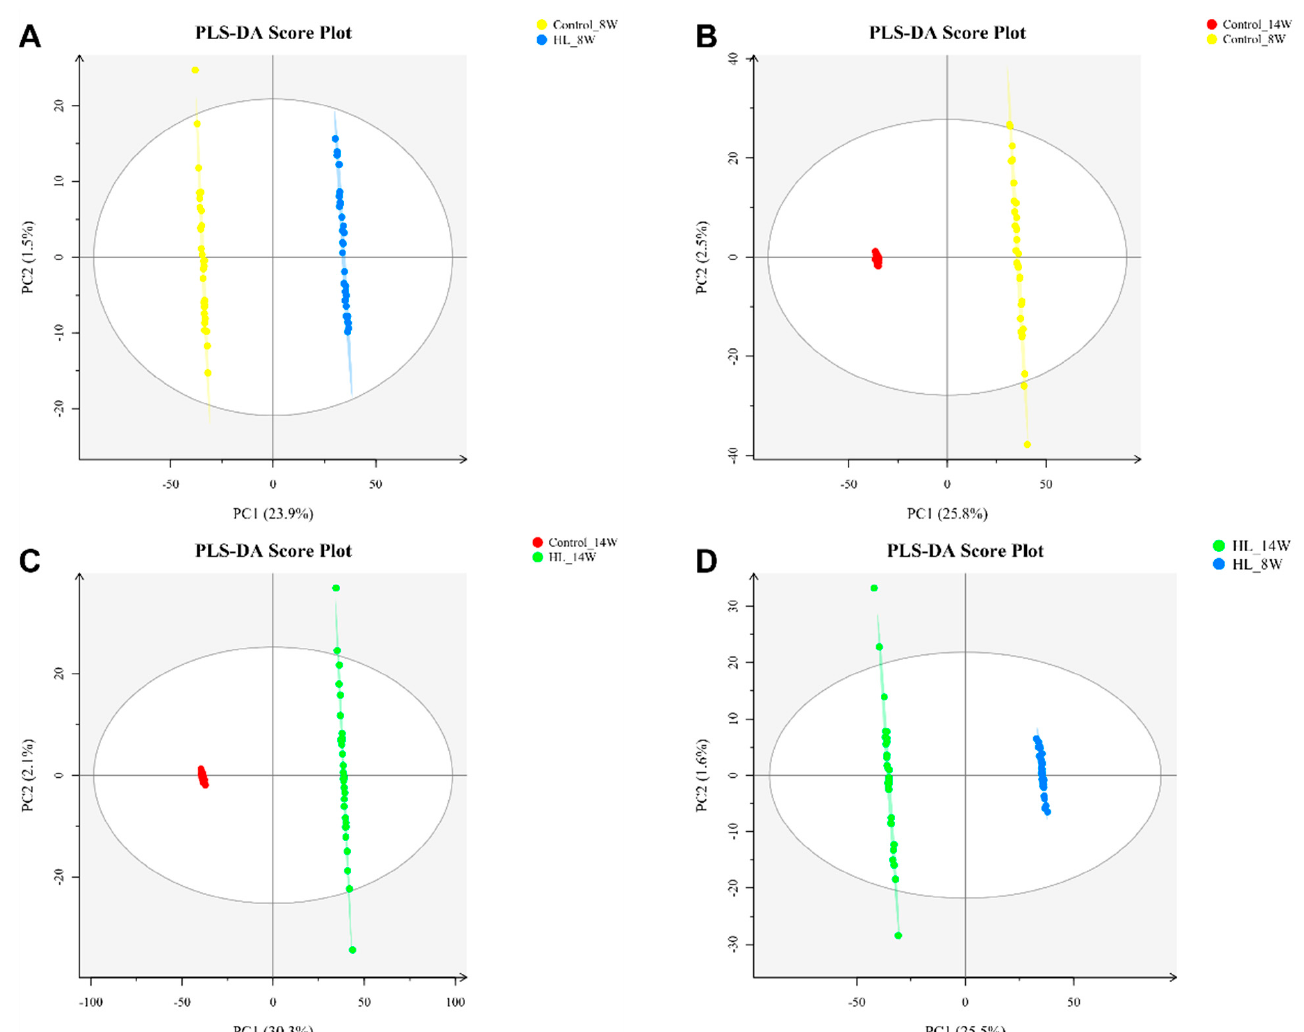
Figure 4. PLS-DA scores of four comparisons in liver tissues. ( A ) PLS-DA score of Control_8W vs. HL_8W. ( B ) PLS-DA score of Control_14W vs. Control_8W. ( C ) PLS-DA score of Control_14W vs. HL_14W. ( D ) PLS-DA score of HL_14W vs. HL_8W. n = 4; the sample repeat for each group was four rats.